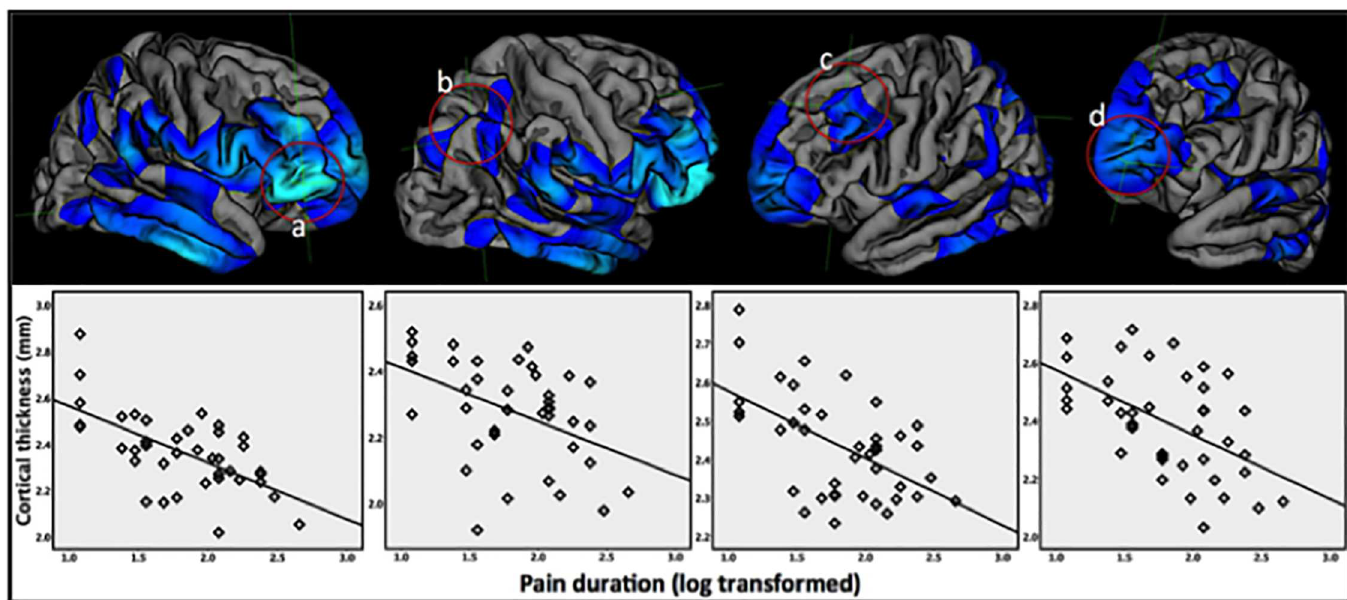
Fig 2. Scatter plots showingnegative correlationsof cortical thickness with log-transformed pain duration for four regions showingstrongest associations (a-d; right pars orbitalis and inferior parietal, and left rostral middlefrontal and frontal pole,